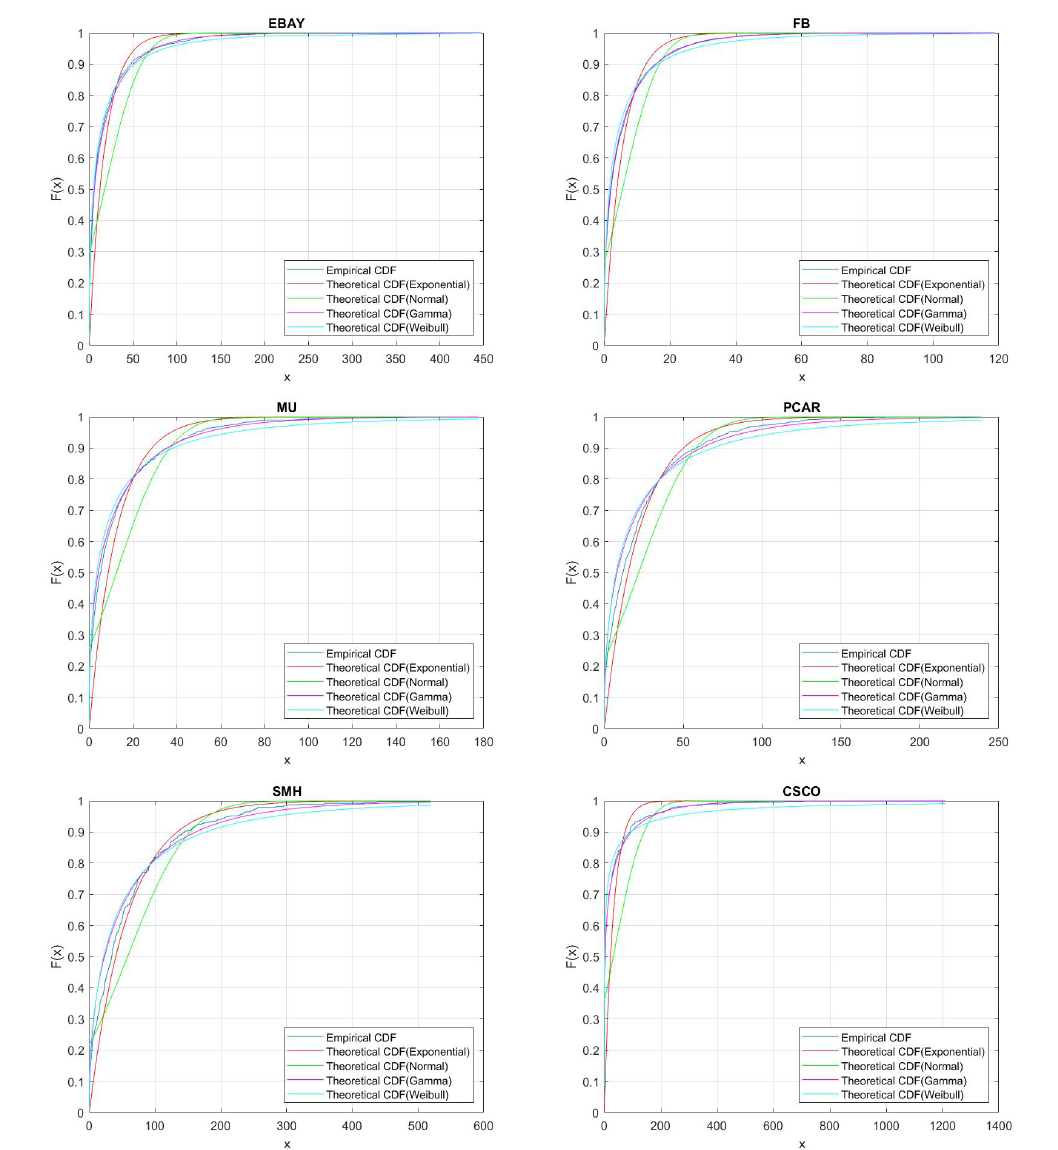
Figure 2. CDF comparison between different